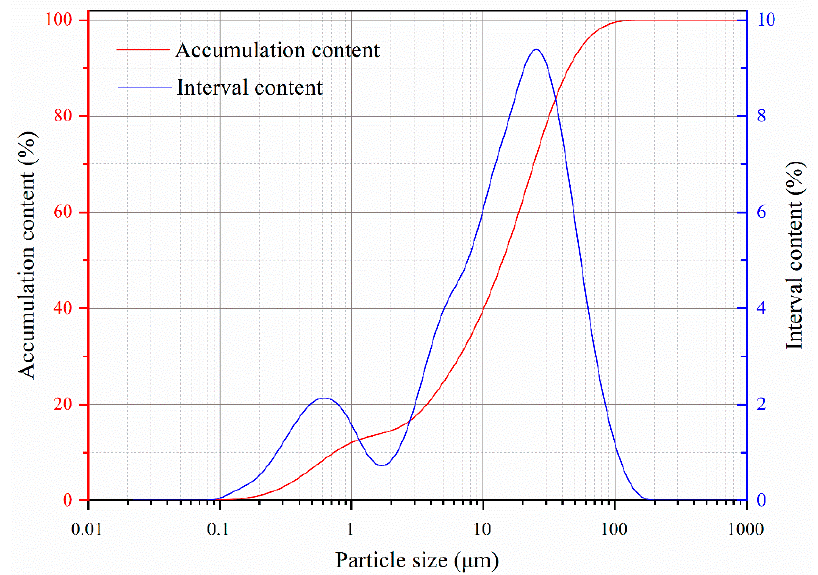
Figure 3. The granulometry chart of intact loess sample.